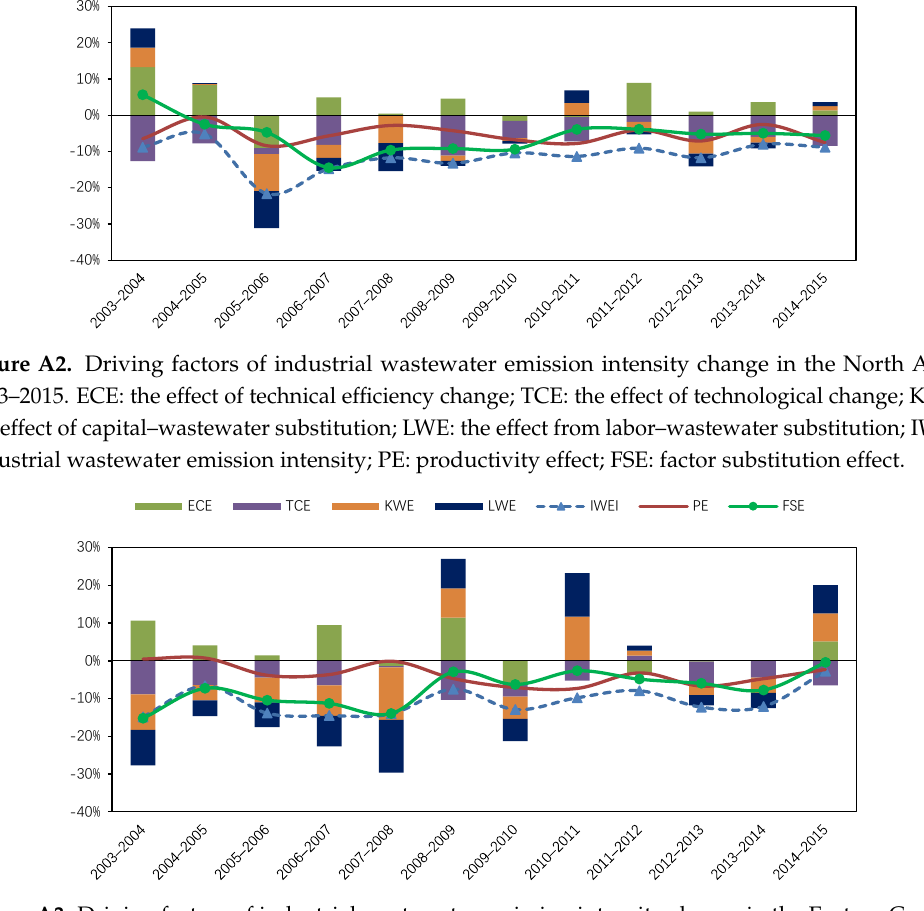
Figure A3. Driving factors of industrial wastewater emission intensity change in the Eastern Coastal Area, 2003 – 2015. ECE: the effect of technical efficiency change; TCE: the effect of technological change; KWE: the effect of capital – wastewater substitution; LWE: the effect of labor – wastewater substitution; IWEI: industrial wastewater emission intensity; PE: productivity effect; FSE: factor substitution effect.